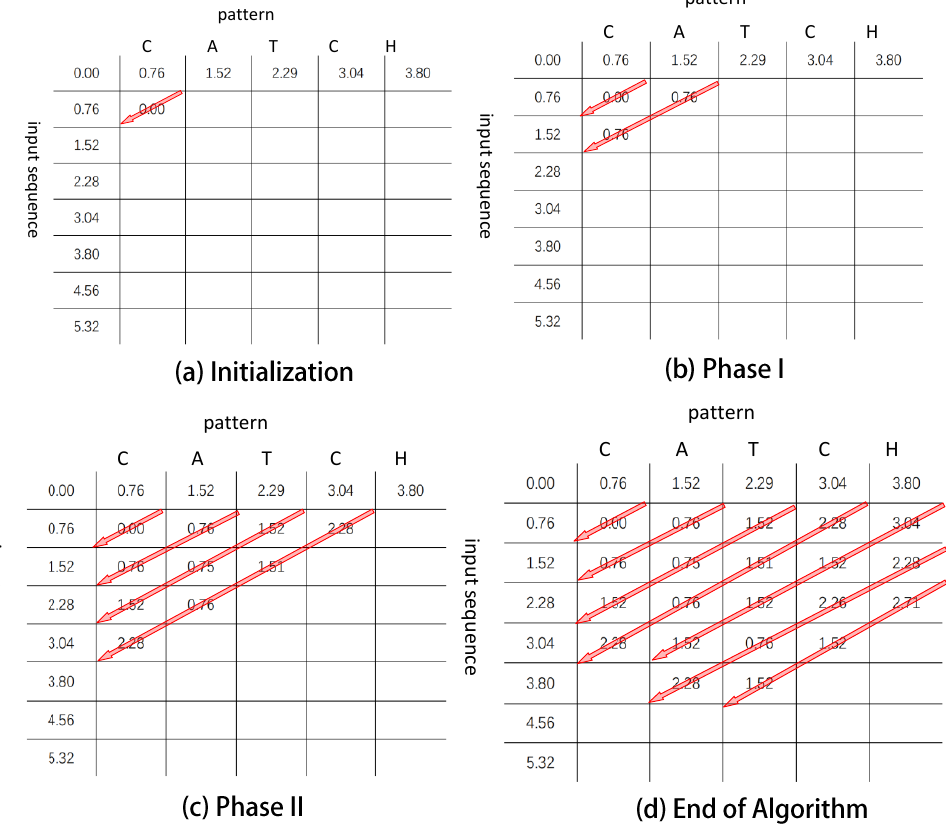
Figure 7. Update process of diagonal jump